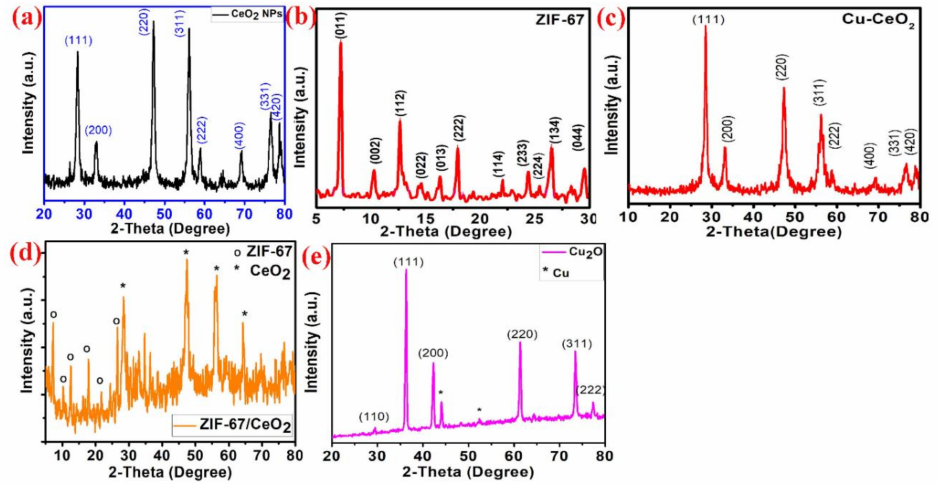
Figure 1. The indexed XRD patterns of ( a ) pure CeO 2 nanoparticles ( b ) pure ZIF-67 ( c ) 10% Cu doped CeO 2 ( d ) nanohybrid of ZIF-67/CeO 2 ( e ) 90% Cu doped CeO 2 (Cu 2